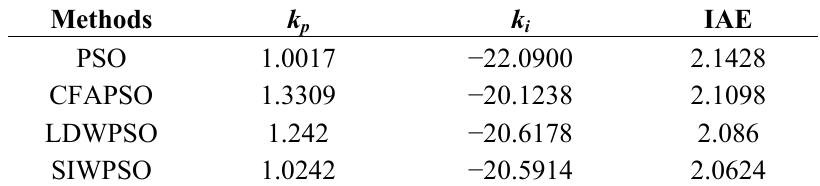
Table 5. The IAE values obtained by Equation (21) for each iteration of the four PSO